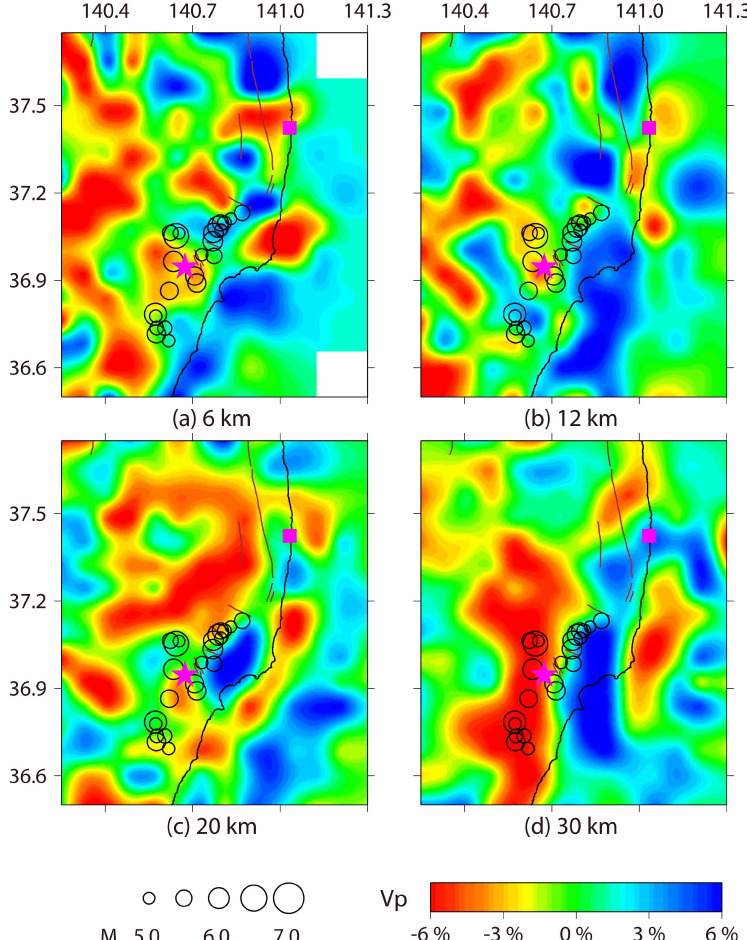
Fig. 3. Map views of the finite-frequency P-wave tomography in the crust under the Iwaki earthquake and Fukushima nuclear power plant area. The layer depth is shown below each map. Red and blue colors denote low and high velocities, respectively. The velocity perturbation (in %) scale is shown at the bottom. The brown lines denote the active